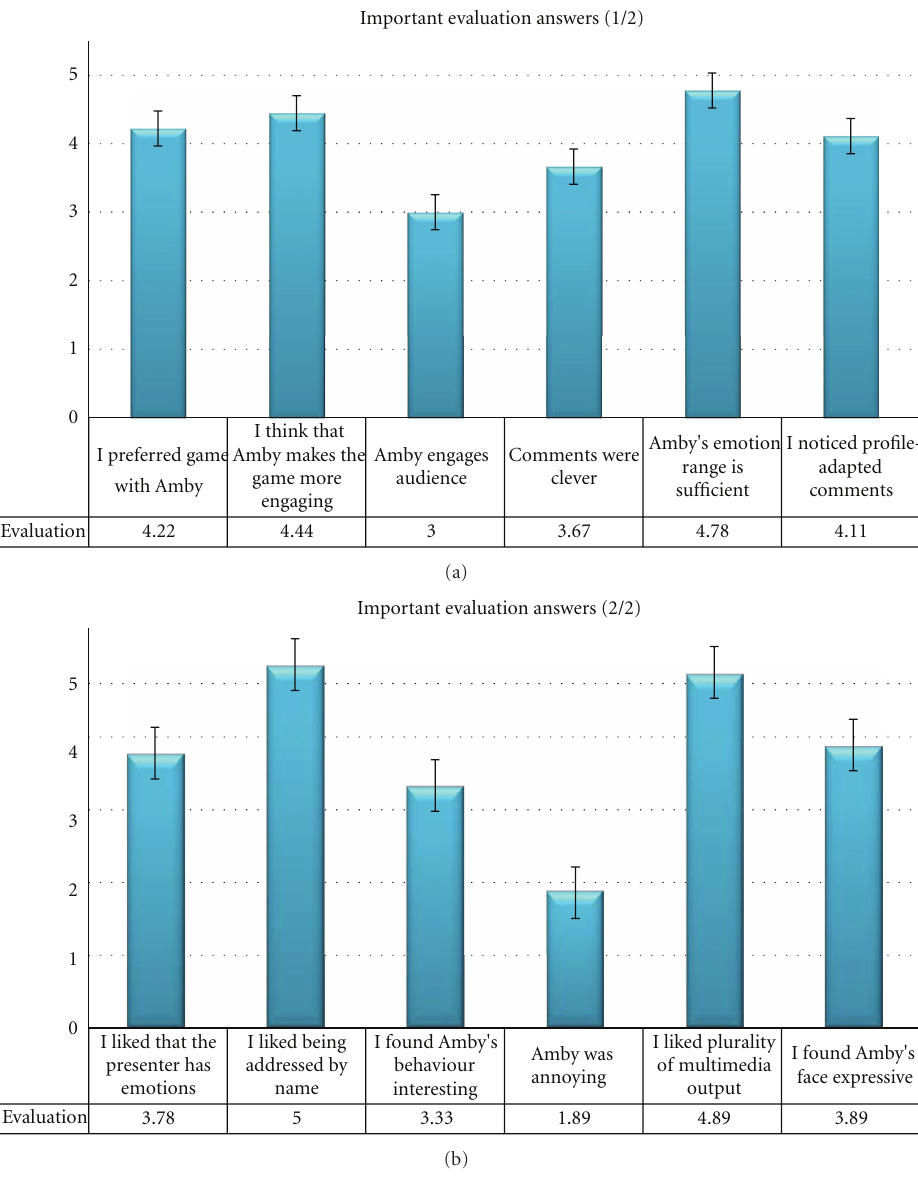
Figure 11: Evaluation diagrams for the most important questions about Amby. For the evaluation we used the Likert scale. The diagrams illustrate the weighted average values (their numeric form can be seen below each question) given by 9 evaluators. The black lines represent the standard